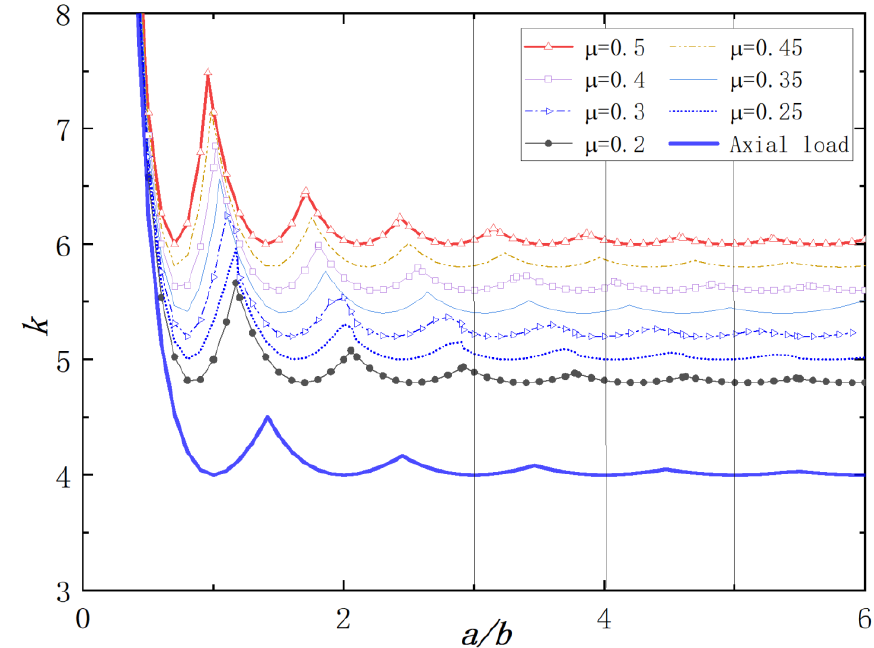
Figure 4. The variation of the buckling coefficient of the side plate with different nominal Poisson’s ratios (bidirectional stress).